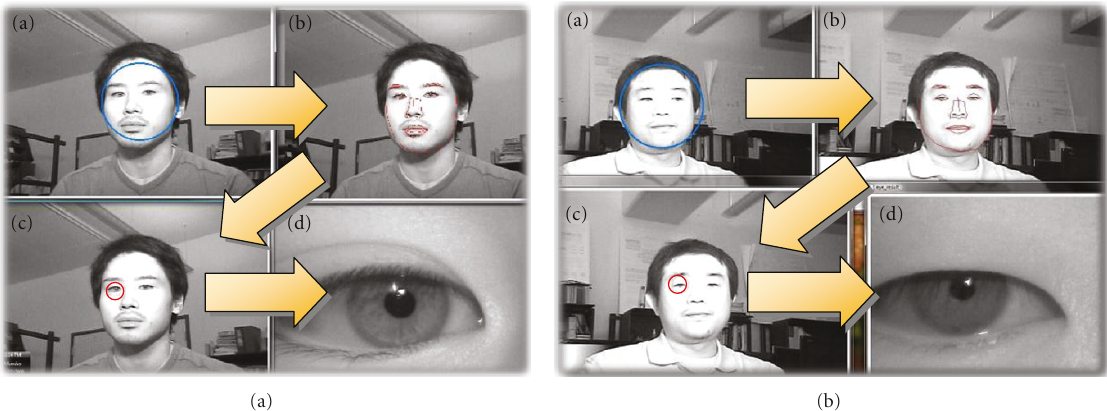
Figure 9: Subjects using the proposed system. This figure shows the visual interface for the system as seen by the user. (a) the face detector detects the face, (b) the ASM model is fitted on the face when it is still, (c) the eye is detected and (d) the zoomed in image of the eye with 200 pixels across the